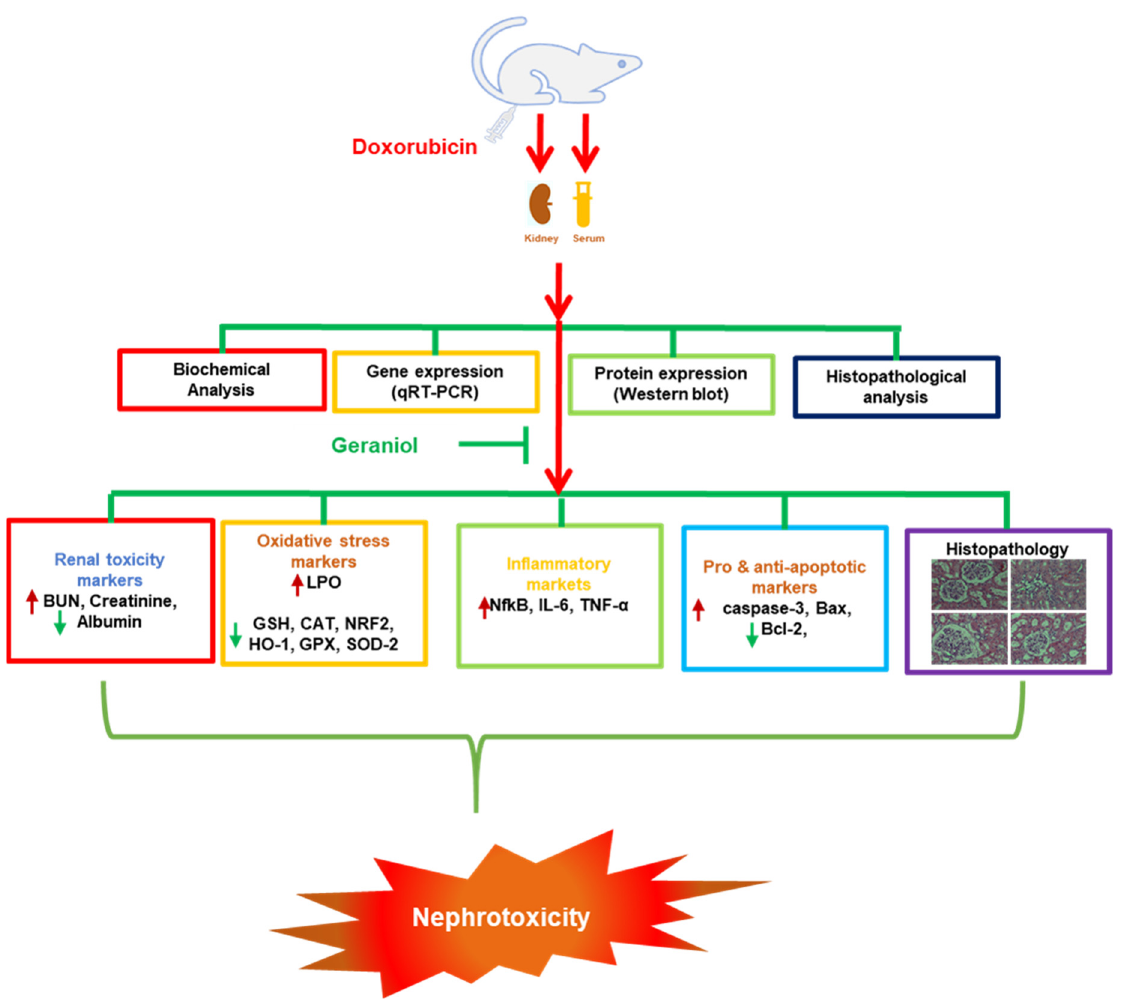
Figure 7. Diagram of the proposed nephroprotective mechanism of geraniol against the toxic effects of doxorubicin.